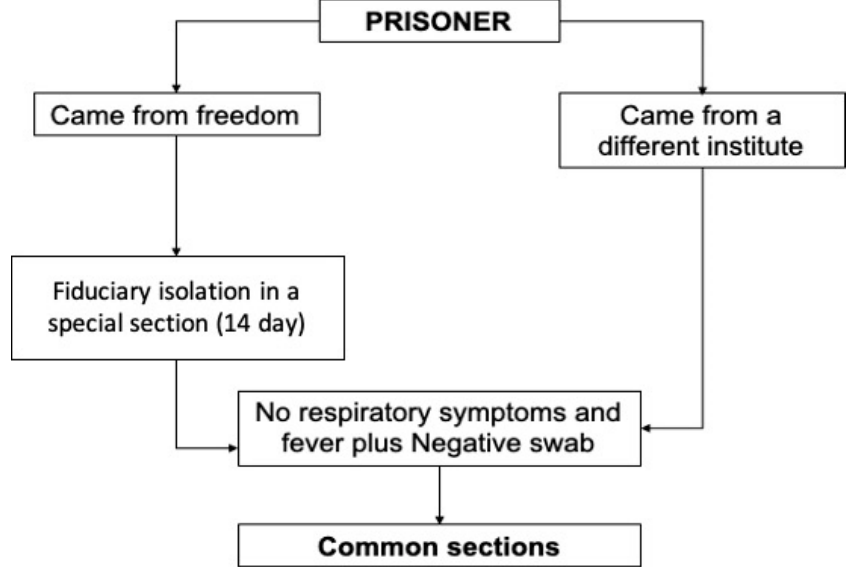
Figure 1. Security protocol for access to the institute for new prisoners.